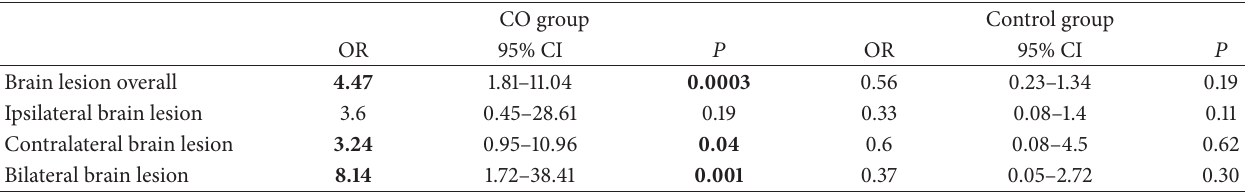
Table 3: Multivariate analysis of the role side of brain infarct related to the operated carotid artery on perioperative neurological outcome (stroke and stroke-related mortality) in 1639 primary carotid revascularizations (overall population brain lesion analysis OR 0.86, 95% CI 0.42–1.77, 𝑃 =